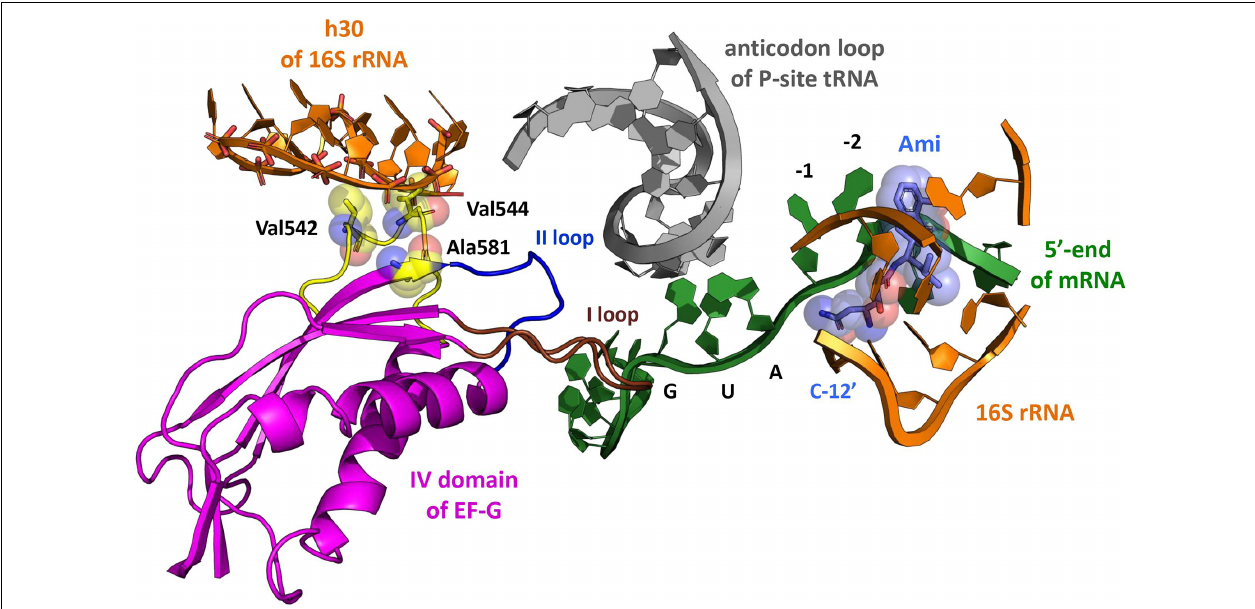
FIGURE 1 | The model of Ami arrangement at the E site of the ribosome complex. The model presents Ami interaction (light blue) with the 5 (cid:48) -end of mRNA (green) and the implied interaction of the 16S rRNA (orange) with EF-G (magenta) amino acids (yellow), providing resistance to Ami. The EF-G conserved loops I and II are shown in brown and blue, respectively. The P-site tRNA is shown in light gray (PDB: 4V7D, 4V5F, 4W2F, and